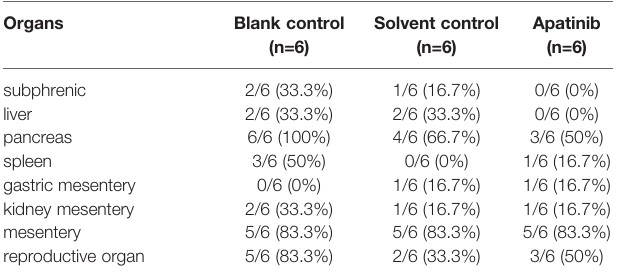
TABLE 2 | The extent of tumor invasion in three groups.